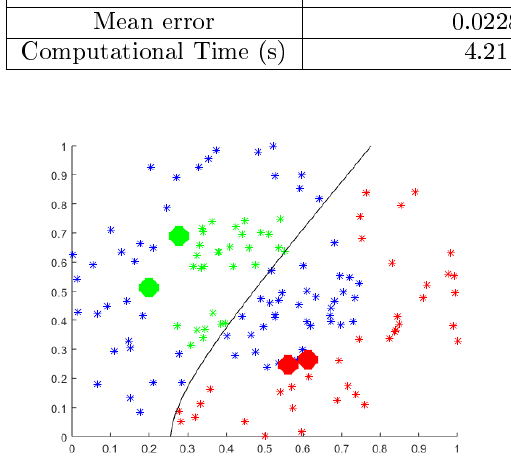
Fig. 4: Classi(cid:28)cation after the (cid:28)rst Boost.